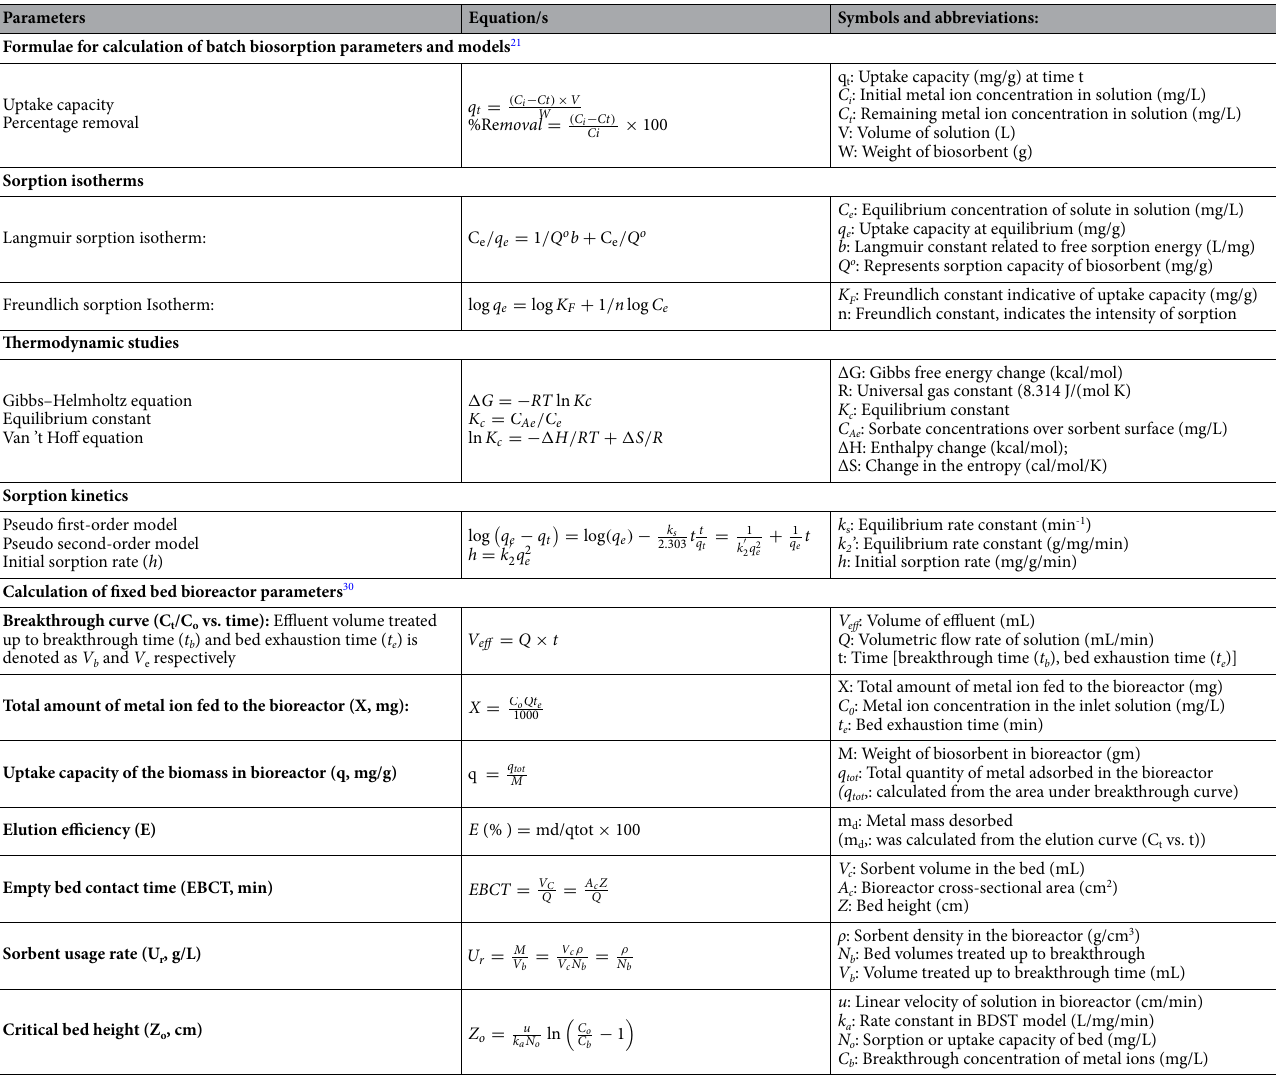
Table 1. List of equations for the calculation of different